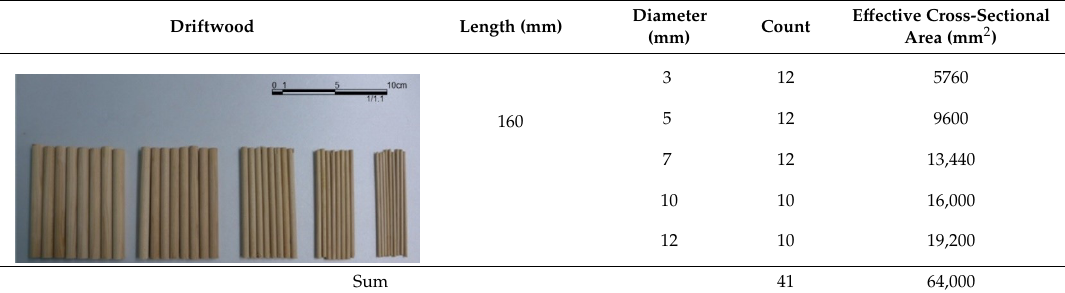
Table 5. Driftwood types and specifications.